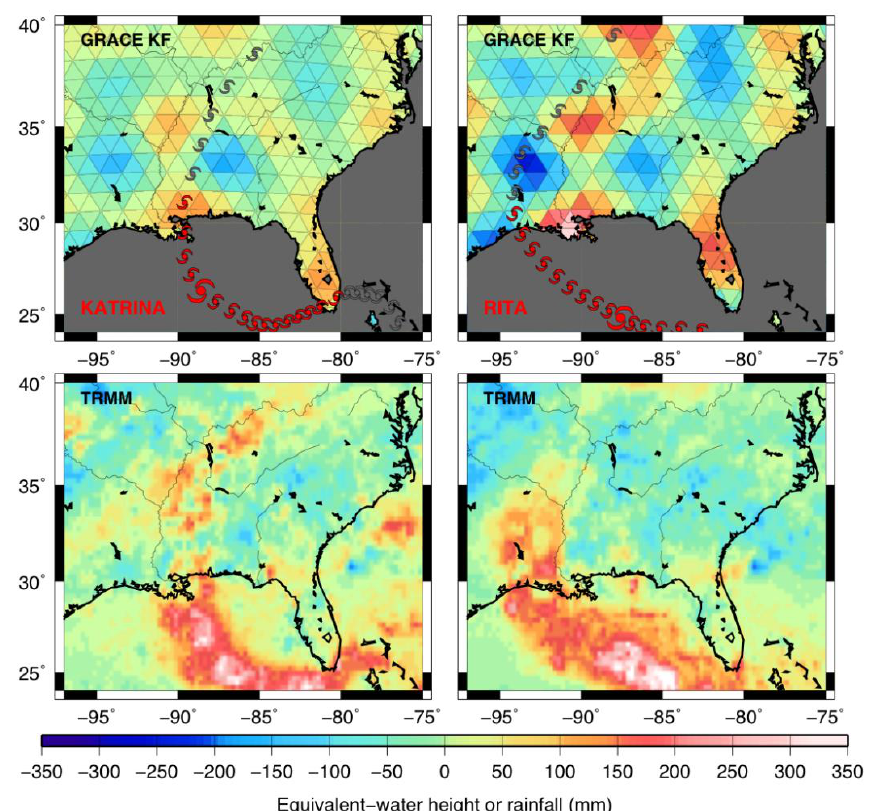
Figure 7. Di ff erences of weekly-averaged KF solutions before and during the Katrina and Rita passages ( top ); and comparison with the anomalies of TRMM precipitation for the same periods ( bottom ). Daily rainfall maps are provided by NASA (https: // pmm.nasa.gov / data-access / downloads / trmm). Katrina and Rita paths are extracted from the NOAA website (http: // www.climate.gov). Grey and red symbols are for tropical depression and category 5 hurricane, respectively. The KF solution di ff erence maps reveal the positive and negative variations of water mass along the paths of the depressions that cause strong showers. The highest water storage variation is located in the coastal region of Louisiana.